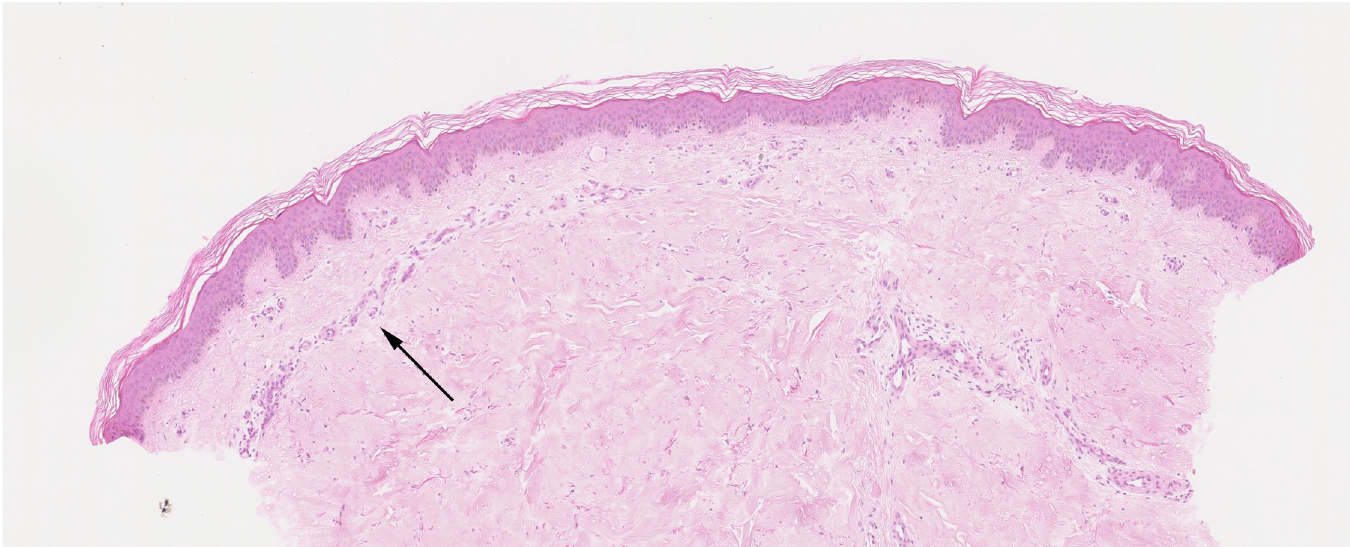
Fig 4. Example of a livedo pattern. The right side of the biopsy shows a normal superficial dermis. On the left side of the biopsy, a livedo pattern is visible (arrow). There are more arteries in the superficial dermis, which are more horizontally arranged (H&E, 50x).